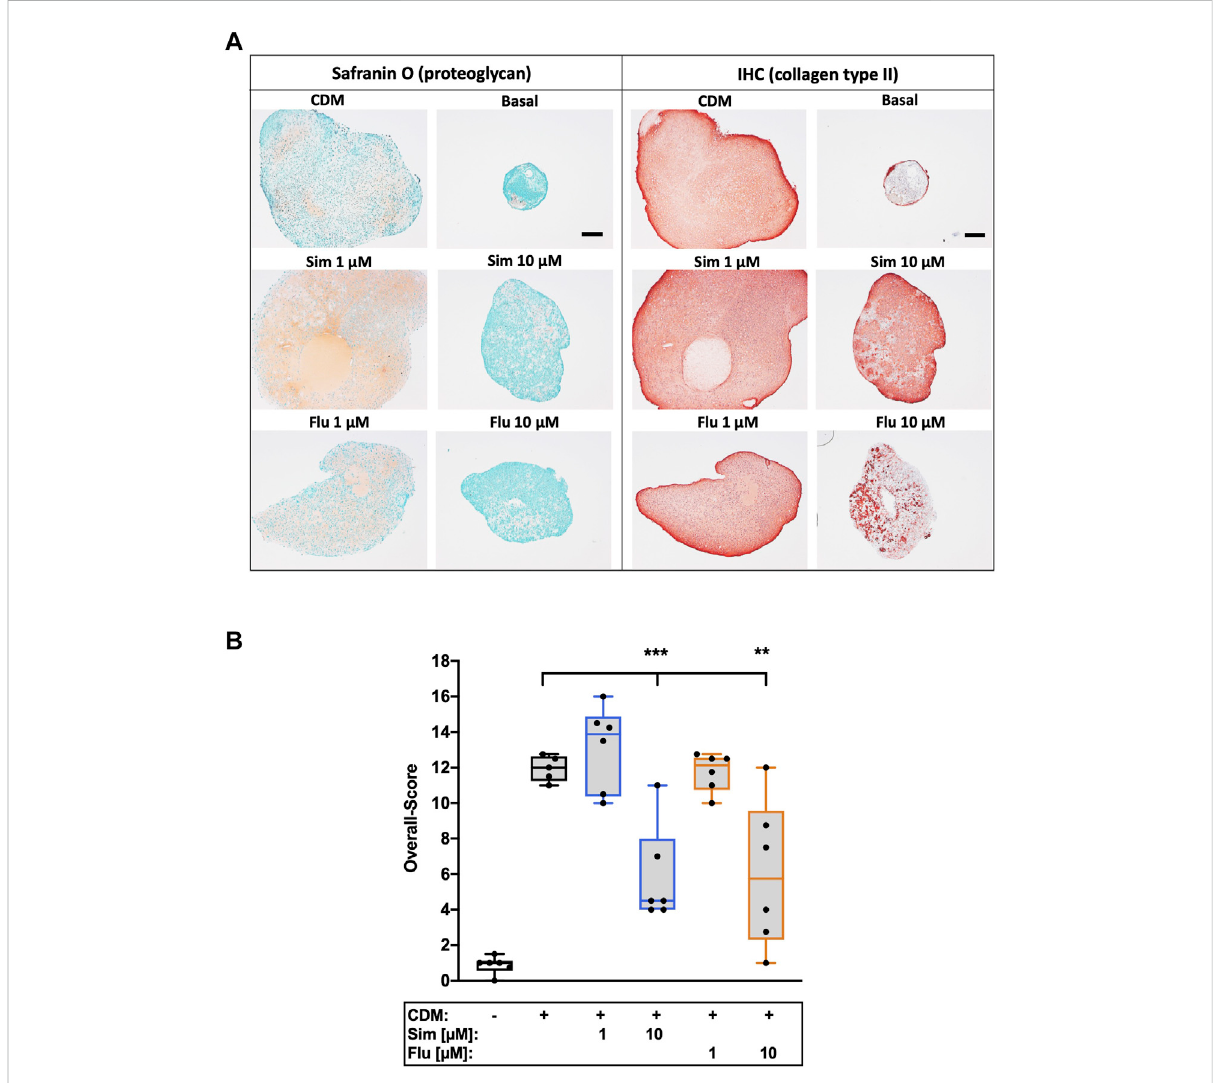
FIGURE 7 Effects ofshort-termapplicationof statins onchondrogenic differentiation of isolated chondrocytes (A) Exemplarily demonstrated thestaining of proteoglycan (Safranin O) and collagen type II (IHC) of the redifferentiation of high passage chondrocytes (B) Chondrogenic redifferentiation was assessed by a de fi ned scoring system. Black scale bar = 200 μ m; n = 6. Signi fi cant differences between groups were depicted as [versus CDM] ** = p < 0.01; *** = p <